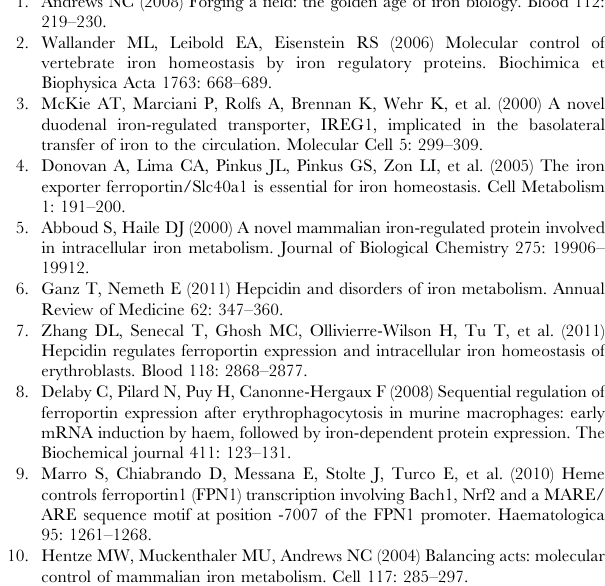
Figure 3E. (J) Quantitation of FPN protein expression in HepG2 Table S1 List of genes involved in cellular iron ion homeostasis from gene ontology (GO: 006879) analysis, using the micro- RNA.org and TargetscanHumanv6.0 databases. Table S2 A list of miR-485-3p target mRNAs predicted by